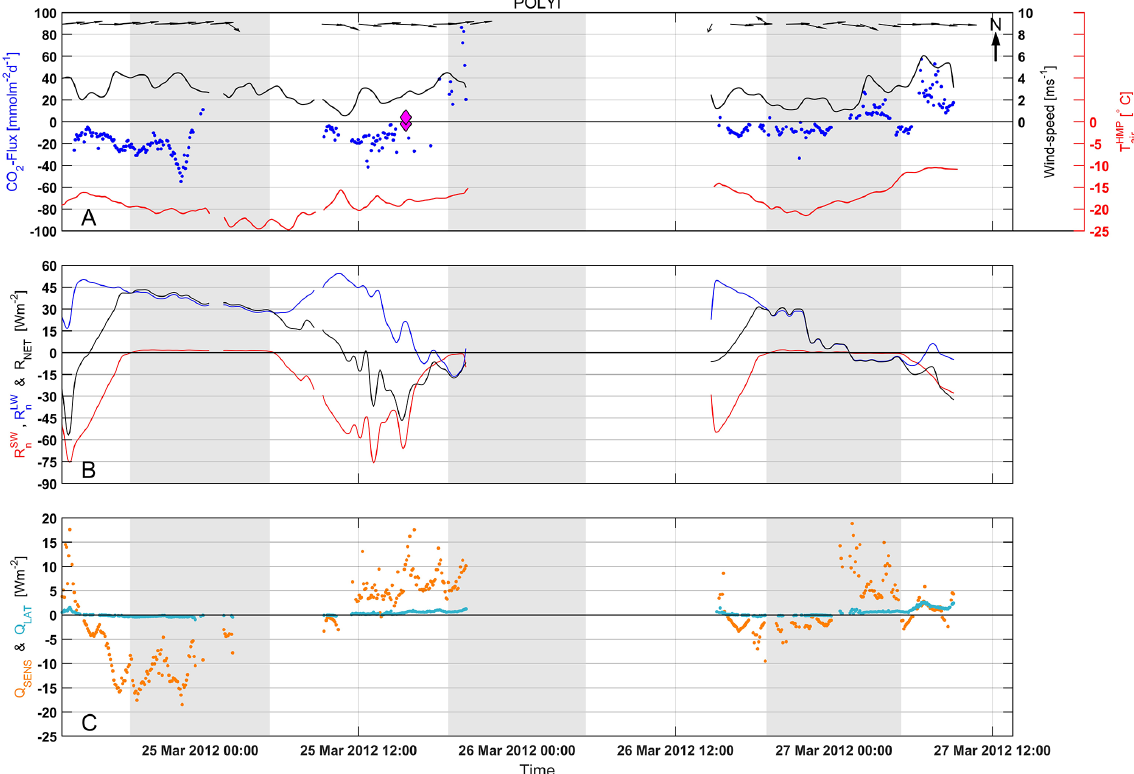
Figure 3. POLYI time series shown as for Fig. 2, but without green bars indicating instrument status in (a) .